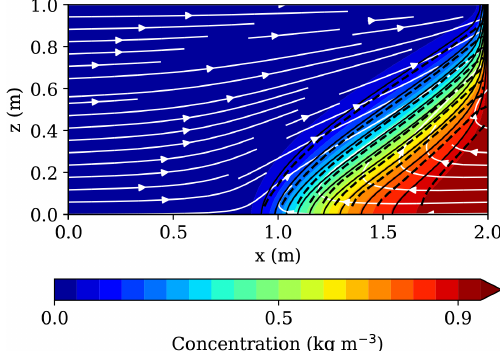
Figure 5. Comparison of TRANSE simulation results for the Henry problem (solid lines and contours) against isochlors computed with SHEMAT (dashed) by Clauser (2003). White streamlines illustrate the spatial velocity